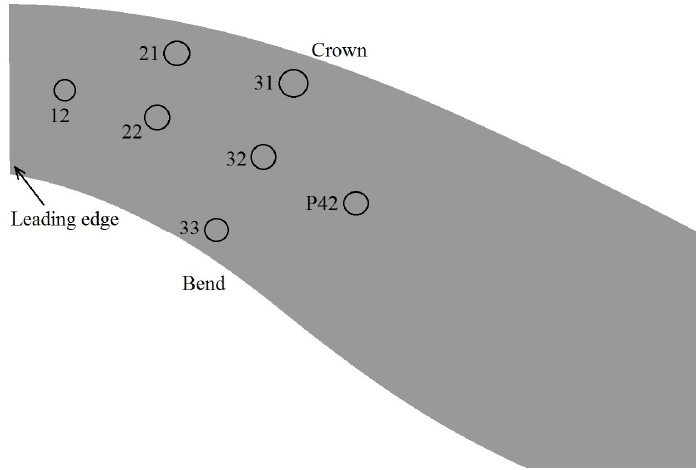
Figure 18. Meridional plane showing numerical monitoring points used to obtain pressure ‐ time data from vortical flow regions.